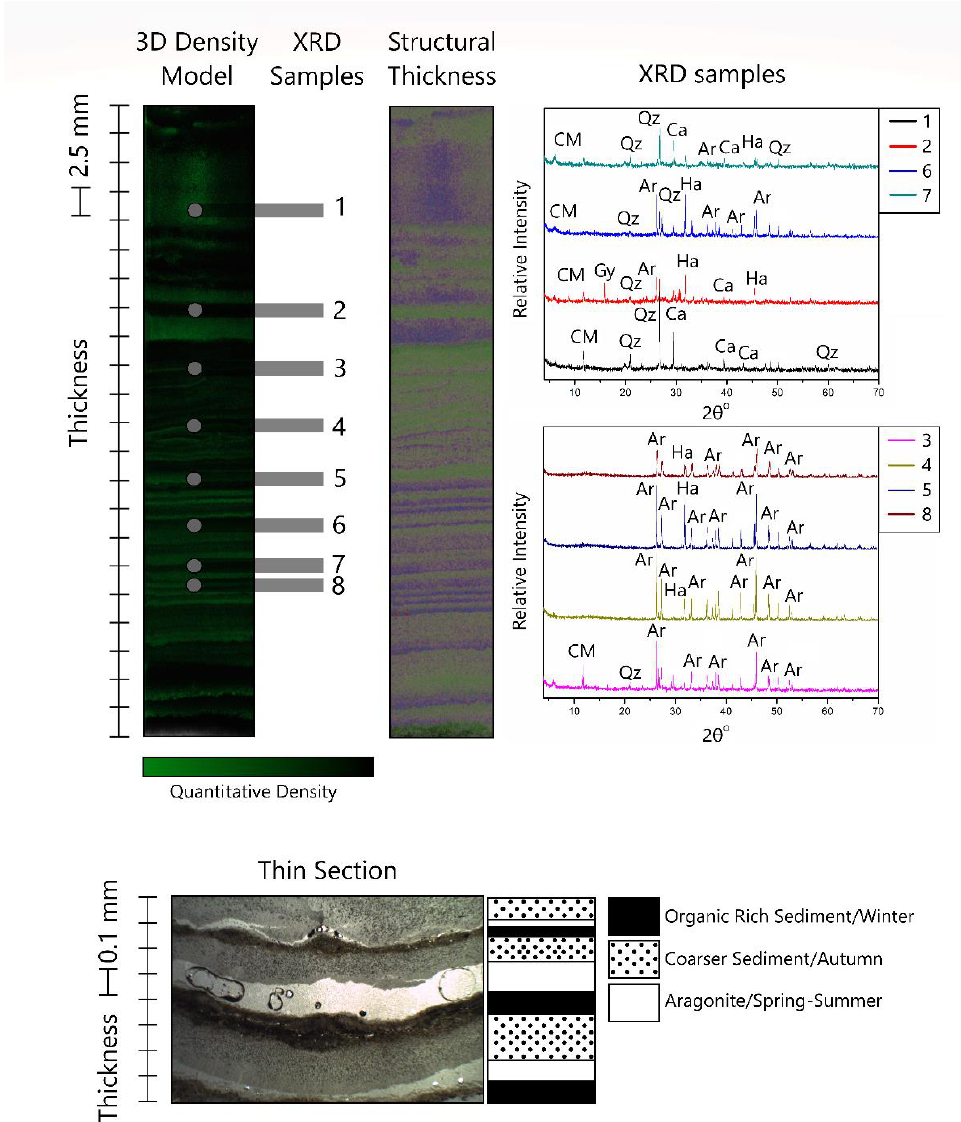
Figure 4. Representative section (core depth: 190–195.5 cm) of μCT analysis presenting the 3D rendered volume and structural thickness model. XRD results of the 8 samples analyzed were selected from white/calcite and brown/bulk laminations. Seasonal sublayers identified through the microscopic analysis are presented with a simplified stratigraphic column.